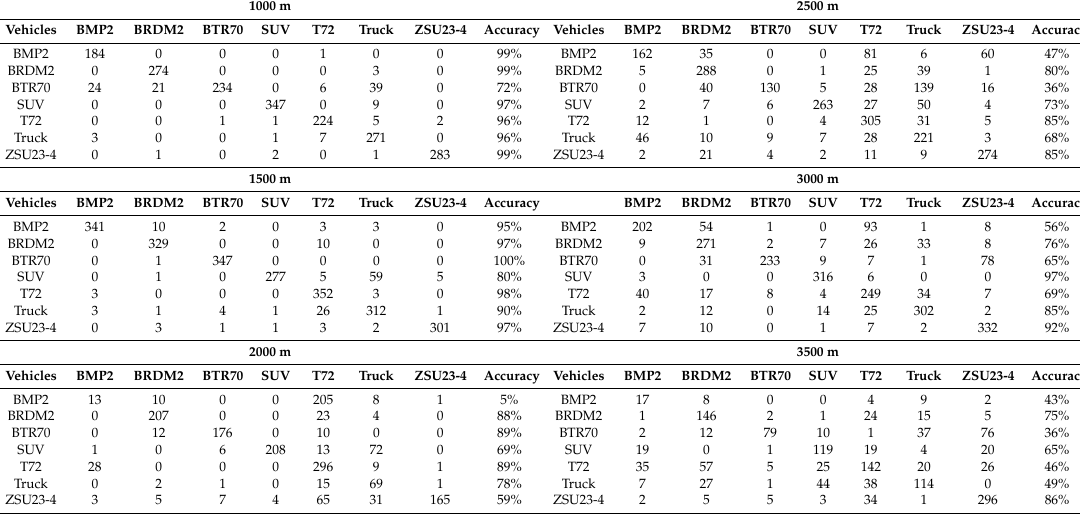
Table 9. Classification results for PCE full case (MWIR nighttime). Left shows the confusion matrix and the last column shows the classification accuracy.